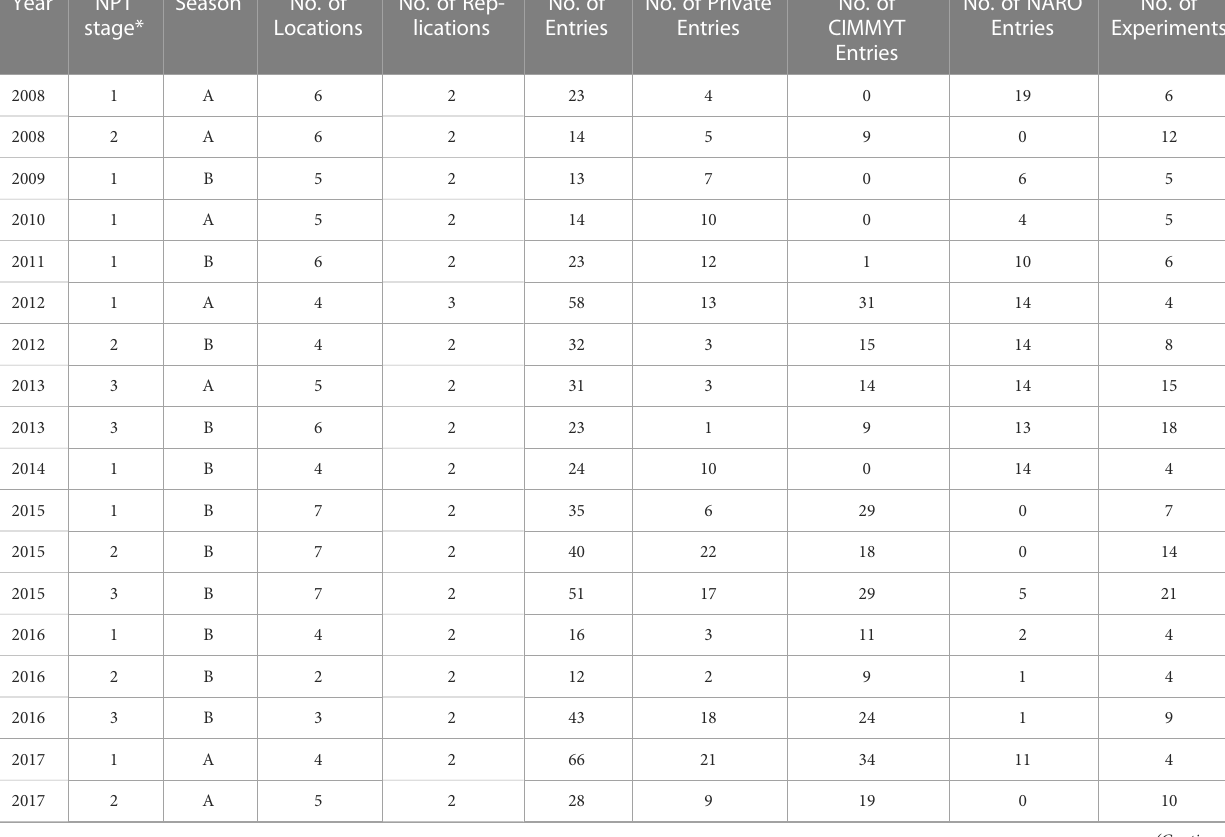
TABLE 2 Summary of the 23 maize National Performance Trials (NPTs) datasets in Uganda used for genetic gain estimation. Year NPT